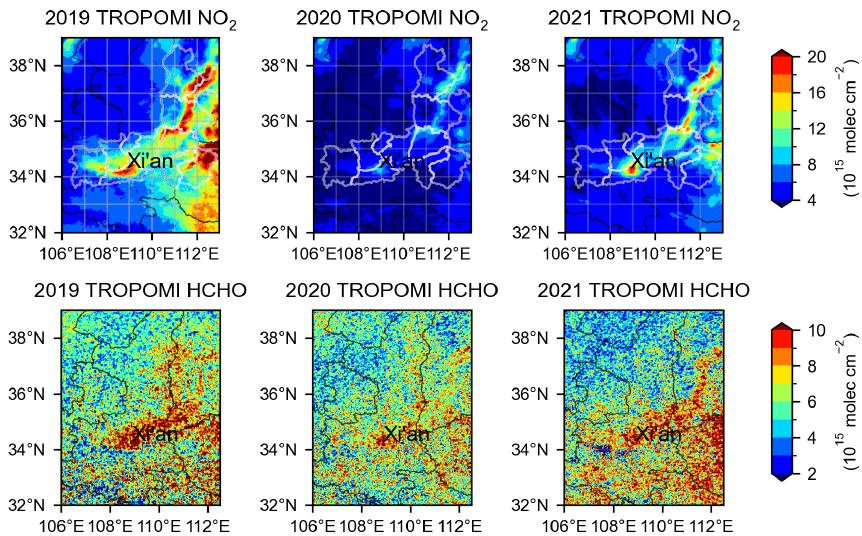
Figure 5. Tropospheric NO 2 column densities, a surrogate of anthropogenic emissions, and tropospheric HCHO column densities, a surro- gate of OVOCs, measured by the TROPOMI satellite instrument in January–February in 2019, 2020, and 2021.